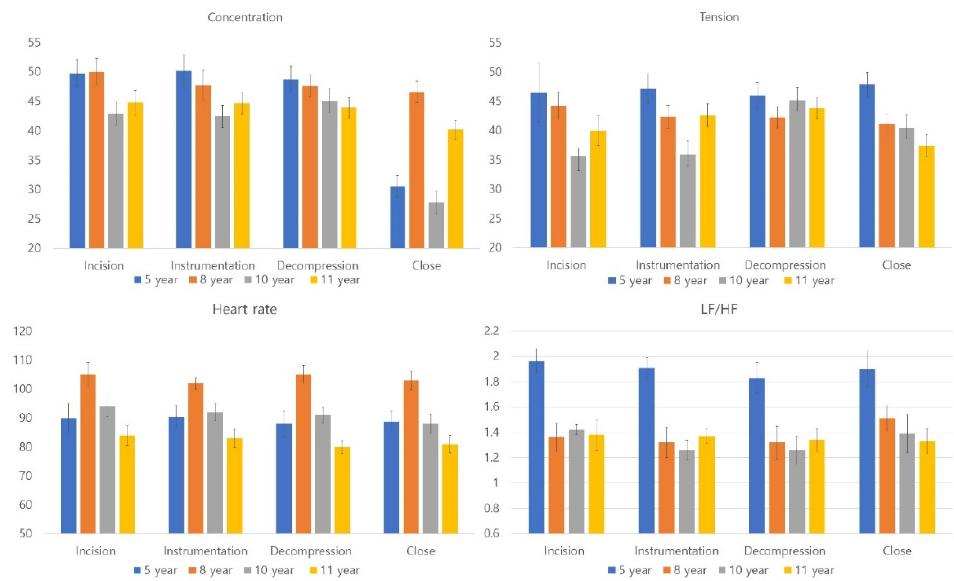
Figure 4. Stress-related parameters based on the work experience of scrub nurses.